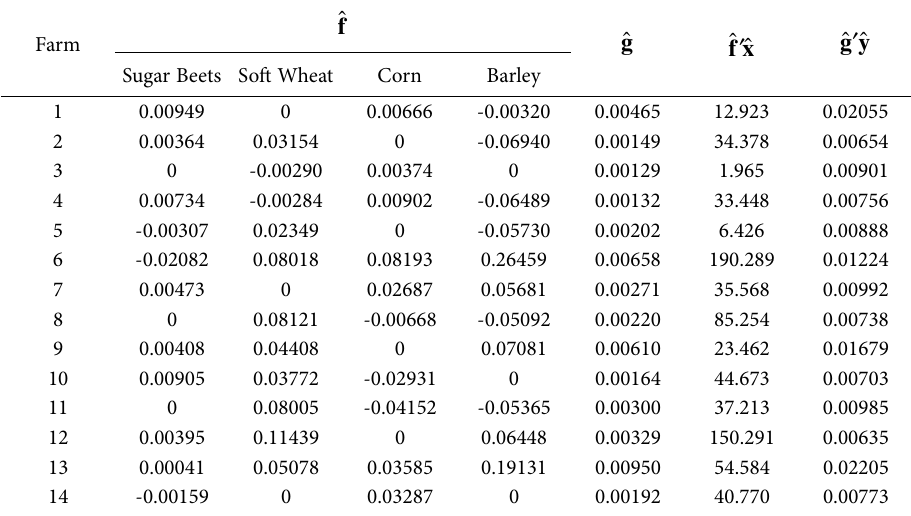
Table 8. Intercepts ˆ f and ˆ g of the marginal cost and input demand functions.